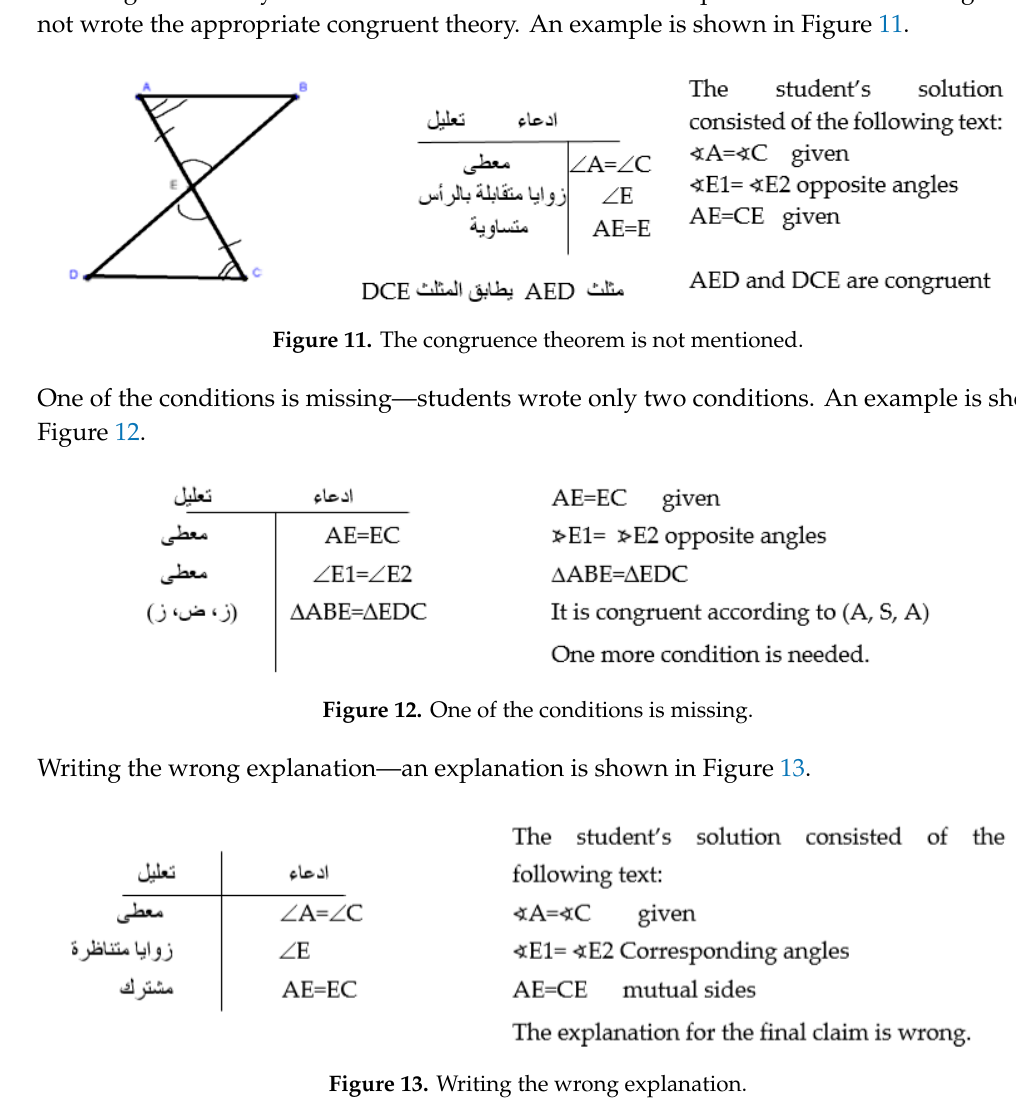
Figure 13. Writing the wrong explanation.